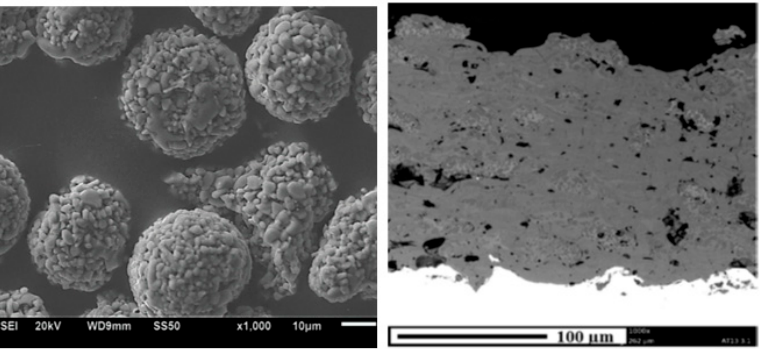
Figure 3. SEM image of Al 2 O 3 + 13 wt.% TiO 2 powder ( left ) and APS coating sprayed therewith ( right ) [23].